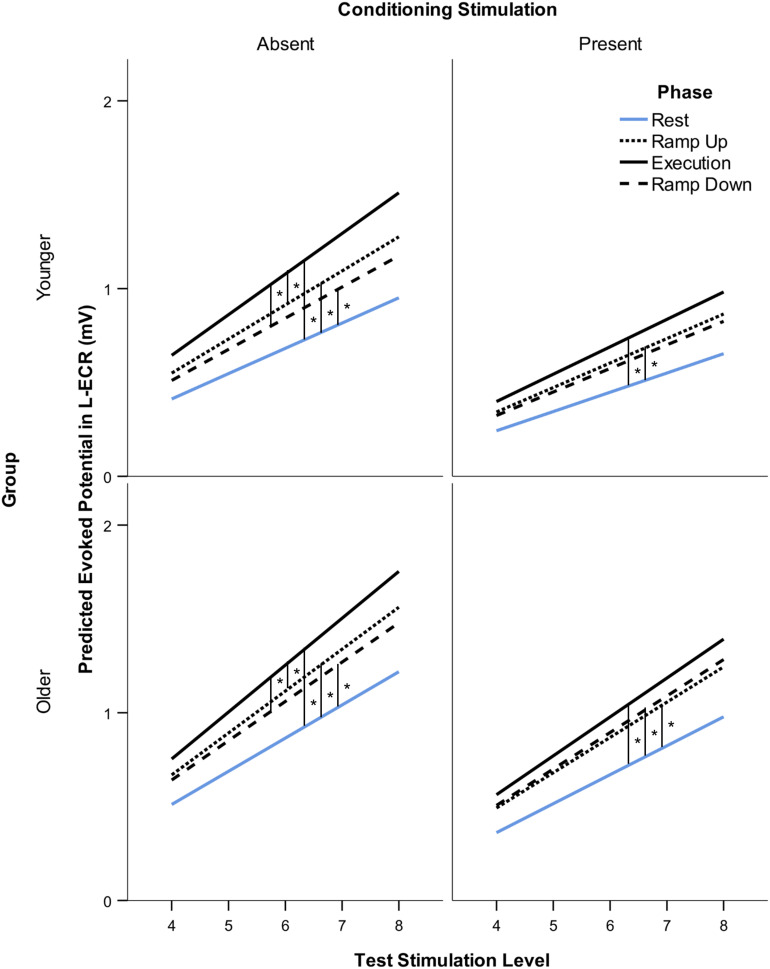
Modeled suprathreshold MEP recruitment slope in response to 5 levels of TMS stimulus intensity (from two intervals above rMT to MAX stimulation intensity) across subjects. Comparison of suprathreshold recruitment slope in the resting L-ECR across phases of R-ECR contraction for younger and older participants in the absence and presence of IHI conditioning stimulation. Asterisks indicate significant differences between slopes for each phase from the mixed-effects spline model, planned contrast t-test *p < 0.05.